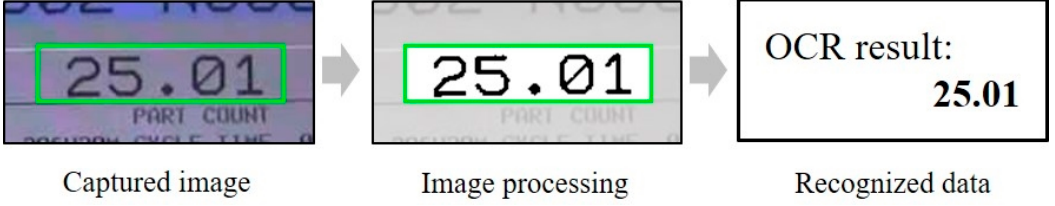
Figure 1. The workflow of optical character recognition (OCR) process.